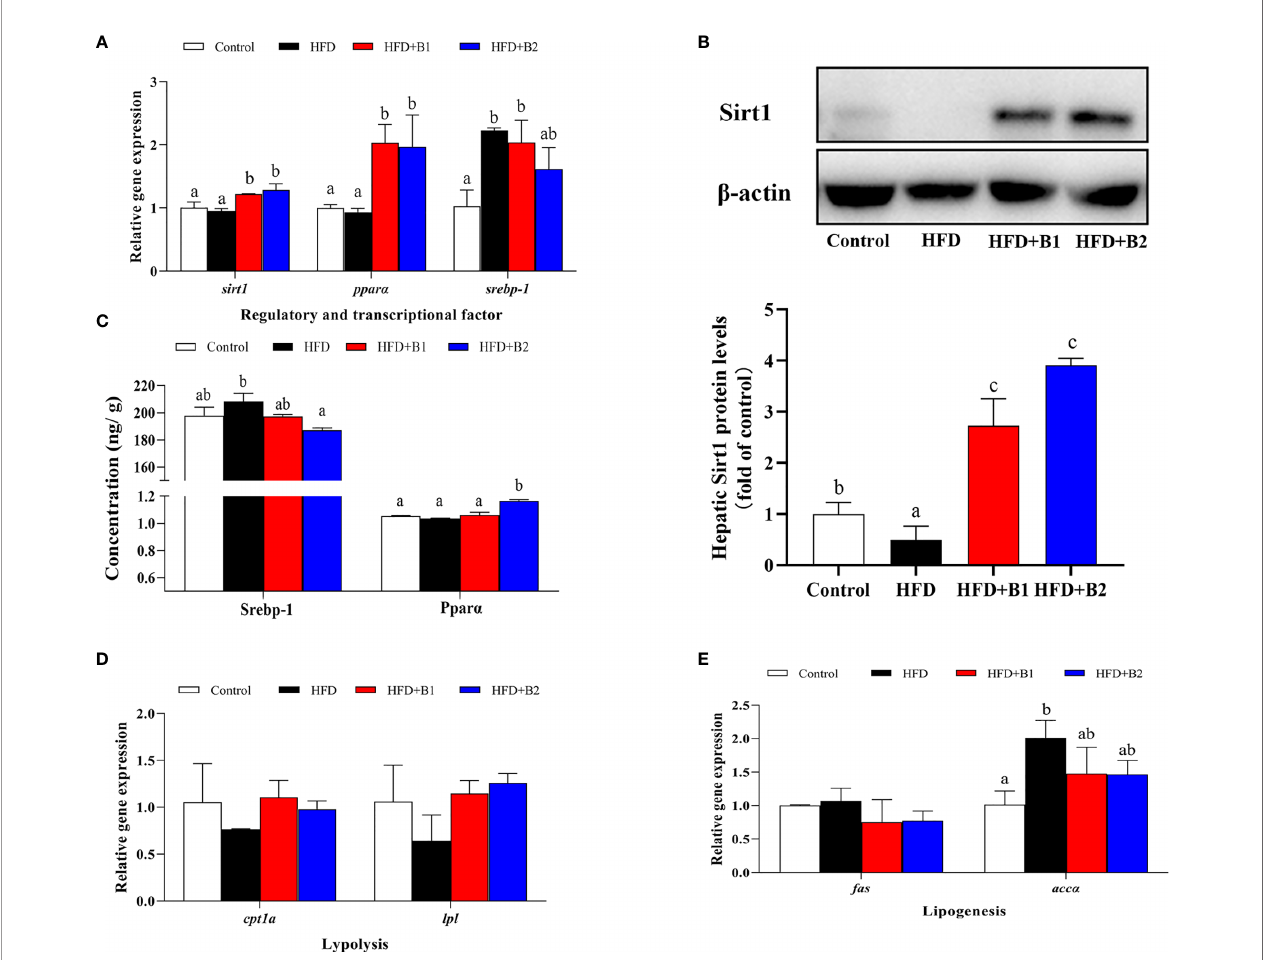
FIGURE 6 | Lipid metabolism gene expression and protein concentration/expression in liver of juvenile black seabream ( Acanthopagrus schlegelii ) (% wet weight) fed the experimental diets [Control: 11% crude lipid; HFD: high-fat diet; HFD+B1: HFD +betaine (10g/kg); HFD+B2: HFD + betaine (20 g/kg)] for 8 weeks. (A) The relative mRNA expression of hepatic sirt1 , ppara , and srebp-1 . (B) The hepatic Sirt1 protein level. (C) The protein concentration of hepatic SREBP-1 and PPAR ɑ . (D) The relative mRNA expression of hepatic cpt1a and lpl . (E) The relative mRNA expression of hepatic fas and acc ɑ . Control was used as the reference group, and the mRNA expression levels of target genes were normalized relative to the expression of b -actin . Values are means (n = 3) with standard errors represented by vertical bars. Mean values for the same gene with different letters were signi fi cantly different ( P <